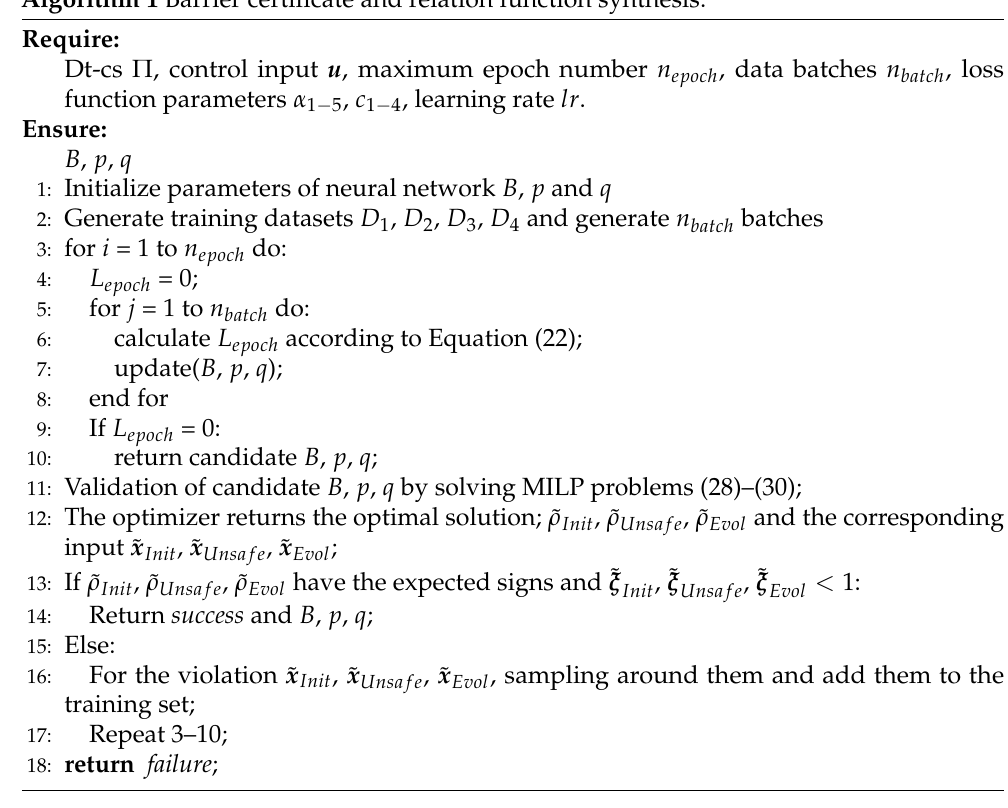
Algorithm 1 Barrier certificate and relation function